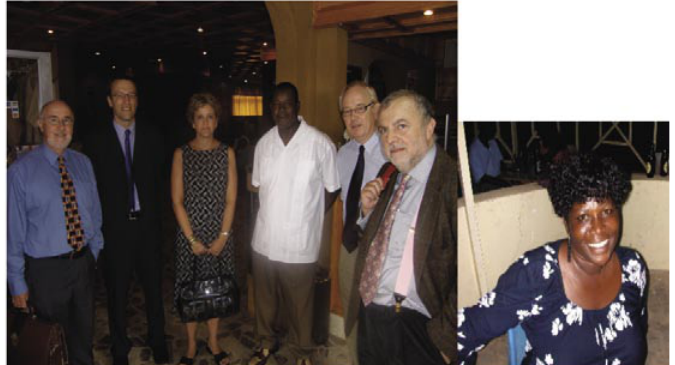
Figure 6. Dignitaries at the official opening of the Train the Trainer course. From left to right Donald Taylor (DFID for Ghana), Chris Brealey (Second Secretary at The British High Commission, Accra), Menna Rawlings (Deputy British High Commissioner for Ghana), Samuel S Mogre (Director of NFED), Michael Wills (Marketing Director for Adaptive Eyecare Ltd), Professor Joshua Silver (Director of Adaptive Eyecare Ltd) and Agnes Addo-Mensah (Head of Special Education) for NFED.